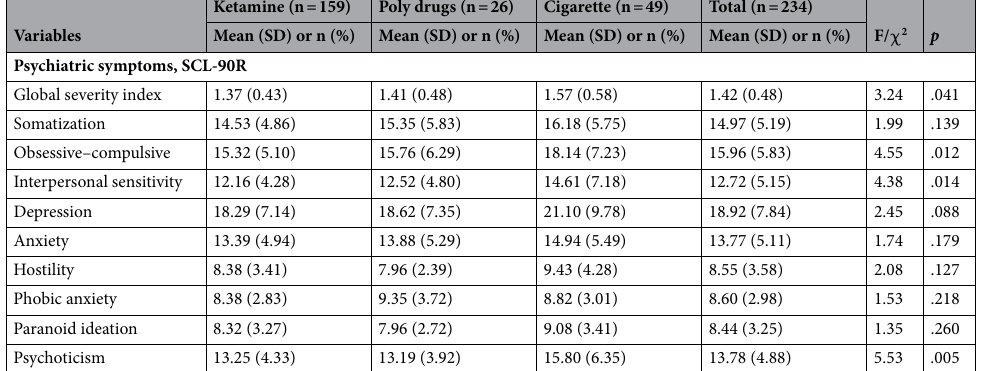
Table 4. Psychiatric symptoms of study participants. Bonferroni correction was used to adjust multiple comparisons. * p < .05/10 =